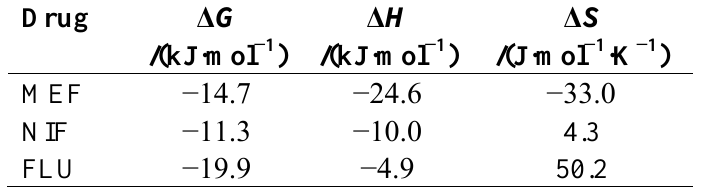
Table 2. Thermodynamic parameters of reactions i.e ., the free energy change (Δ G ), the enthalpy change (Δ H ) and the entropy change (Δ S ) at T = 298.15 K and pH = 7 (buffer